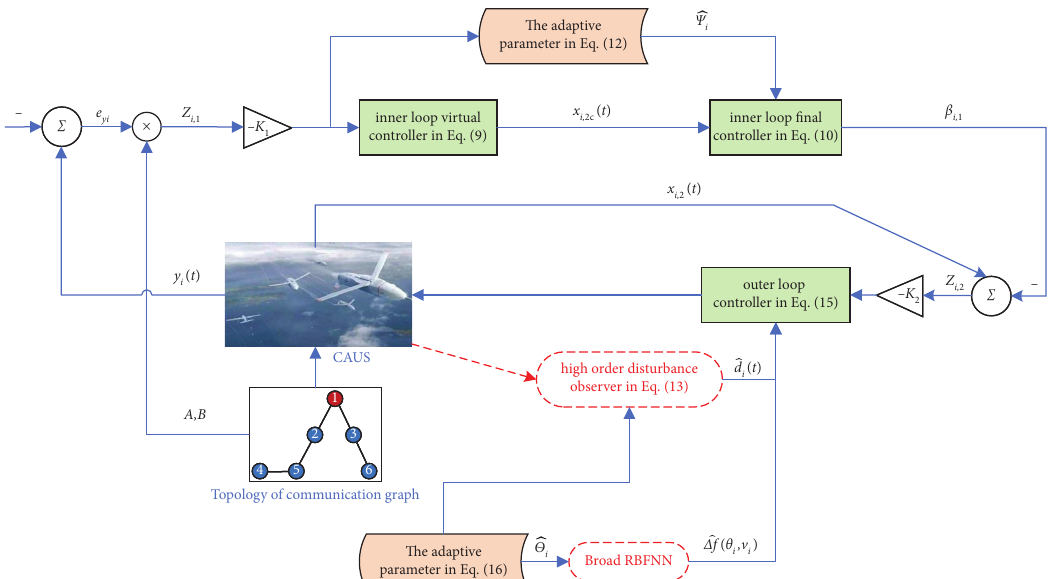
Figure 1: B-RBFNN-based adaptive formation control scheme structure for